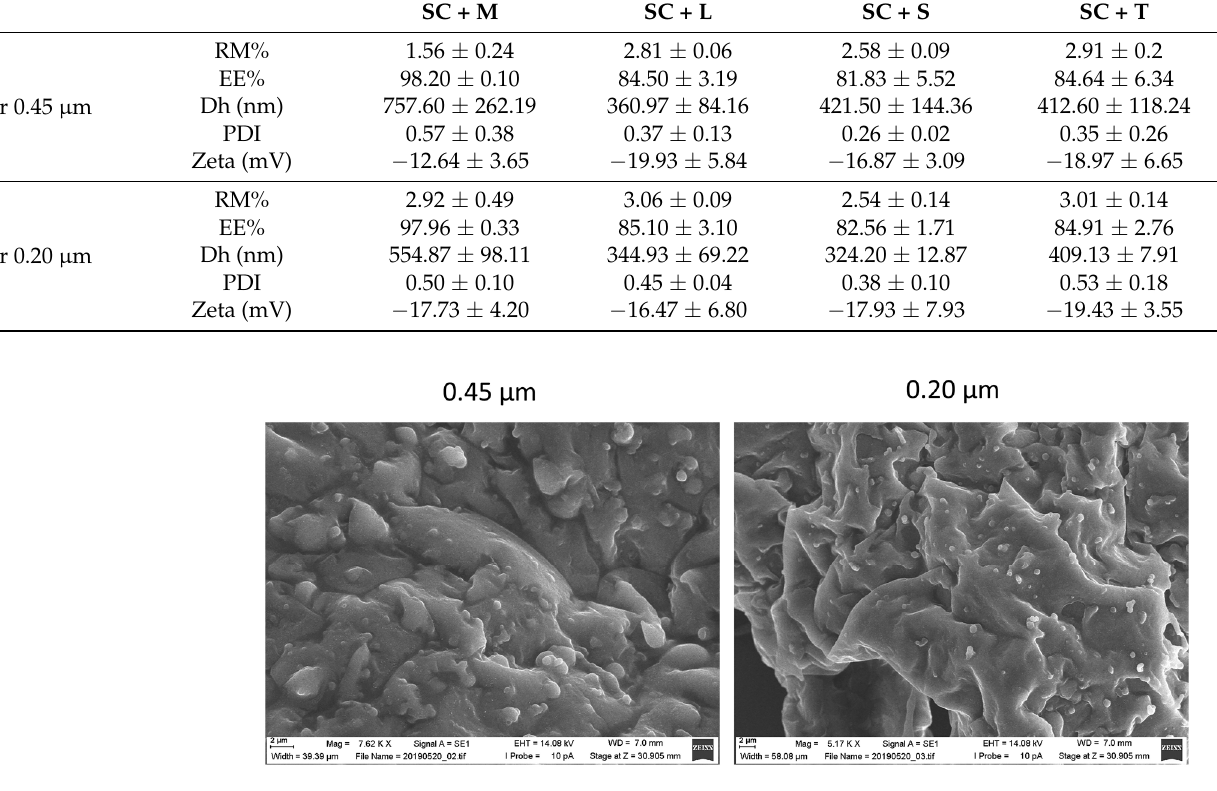
Figure 5. SEM images of lyophilized cakes from lactose samples filtered through 0.20 and 0.45 µ m filters.